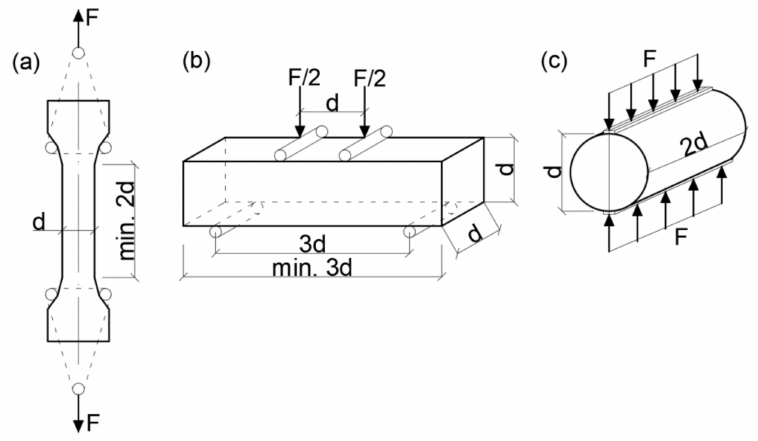
Figure 1. Test methods of tensile strength of concrete: ( a ) uniaxial tensile test, ( b ) flexural test, ( c ) split cylinder test.